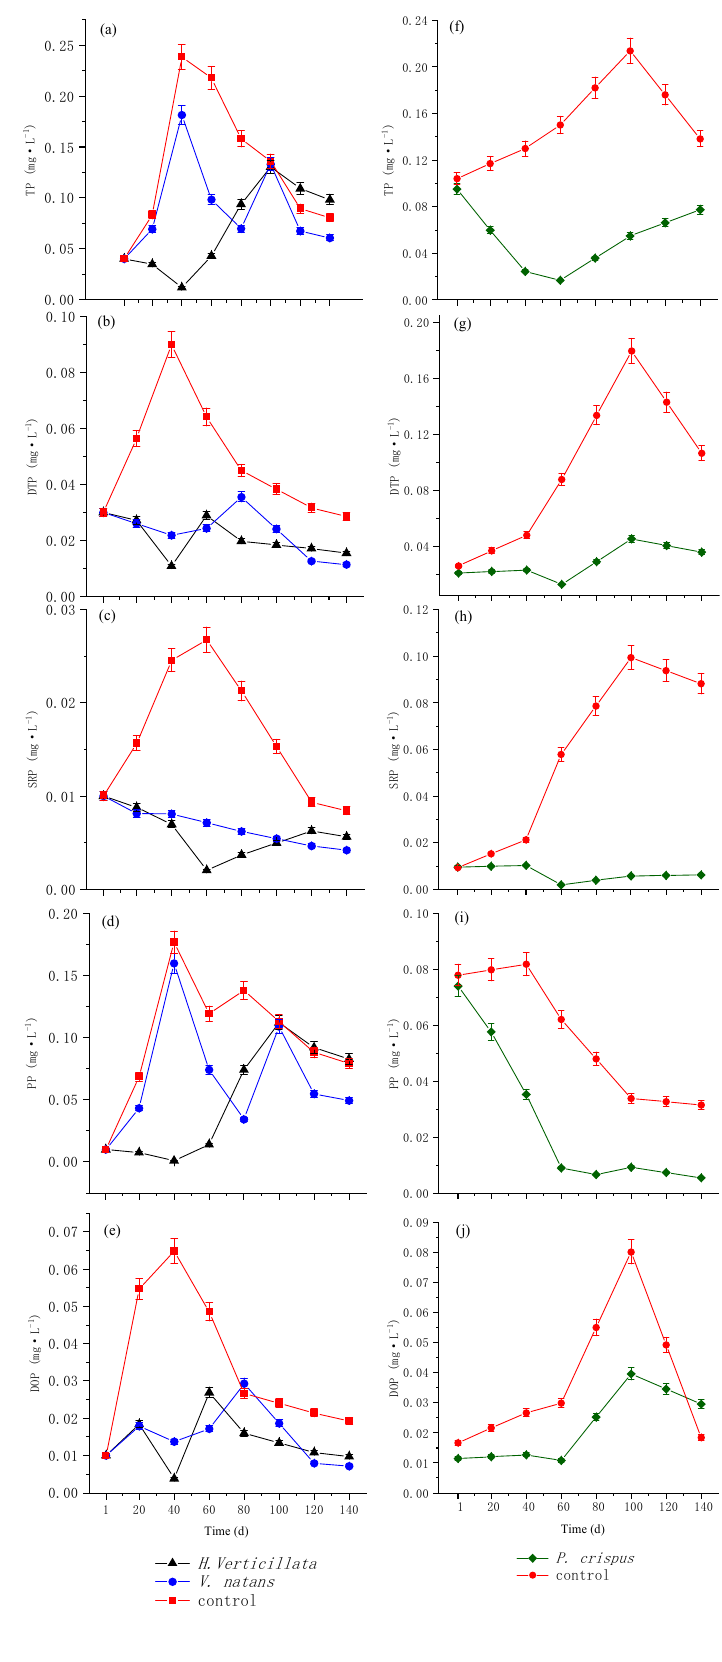
Fig. 3 P concentrations (mg·L −1 ) in water. Results are the mean ± standard